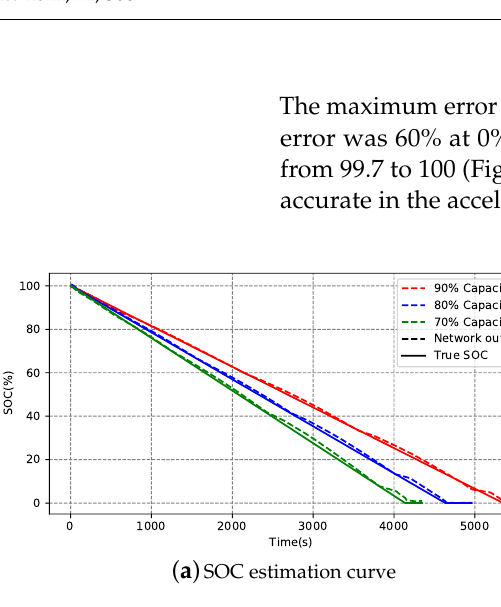
Figure 17. Estimation results at 5 ◦ C.